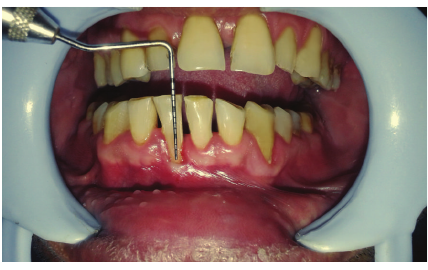
Figure 3: Miller’s Class II recession with 5mm deep defect.